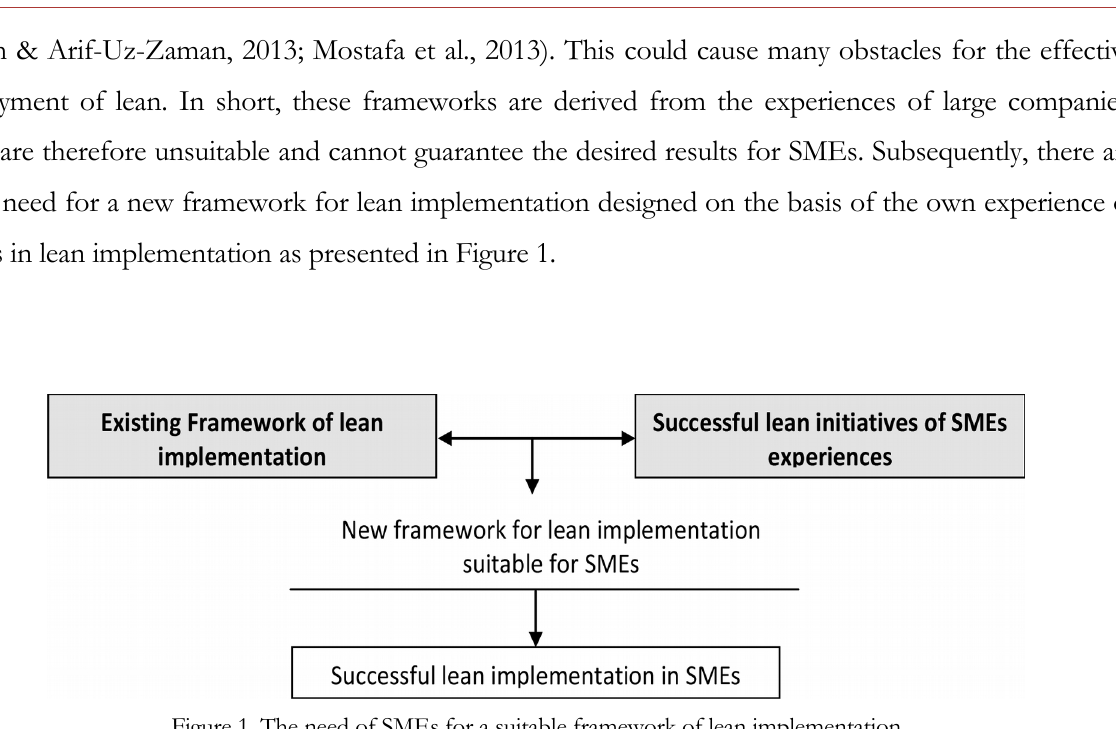
Figure 1. The need of SMEs for a suitable framework of lean